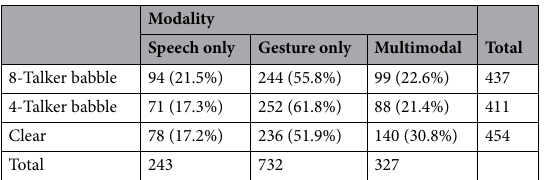
Table 1. Overview of modality usage (total frequency of attempts, and percentage of all attempts per noise level) across noise levels.